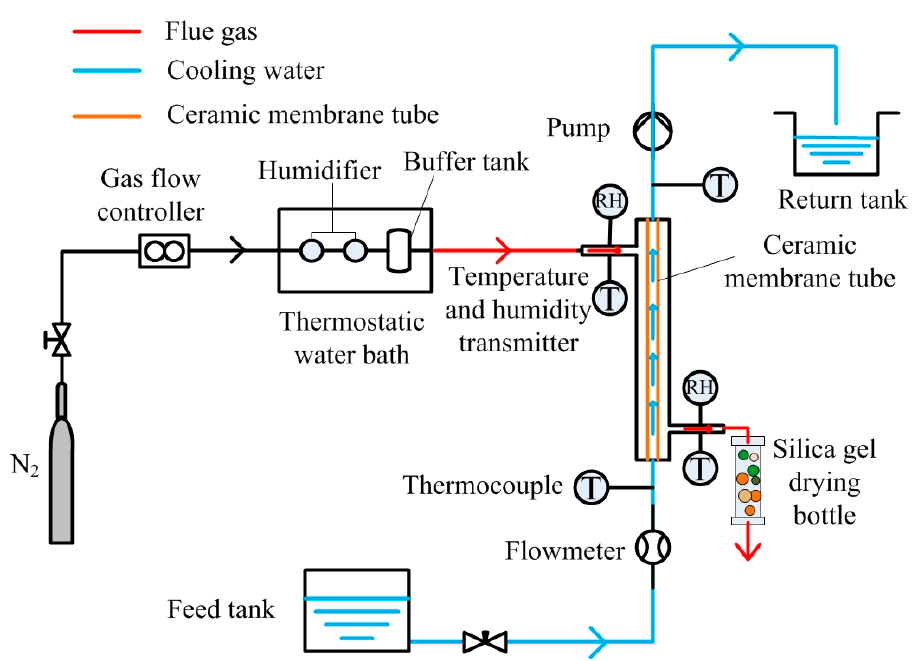
Figure 2. Schematic of experimental system.